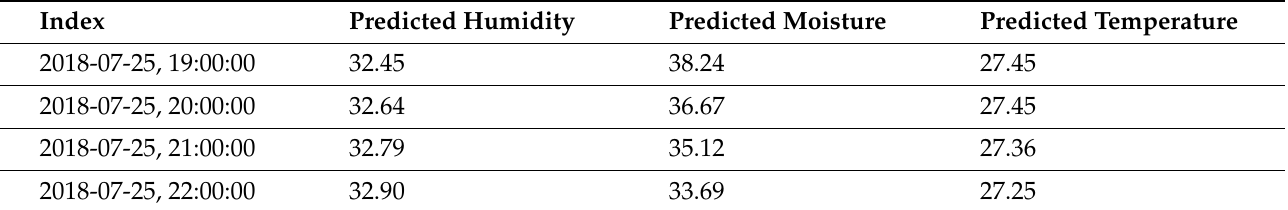
Table 3. Predicted values by neural sensor during training.